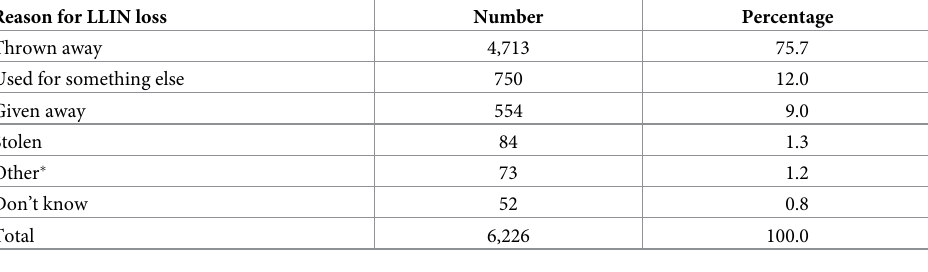
Table 3. Reported causes for long-lasting insecticidal net loss after two years of post-distribution, Ethiopia November